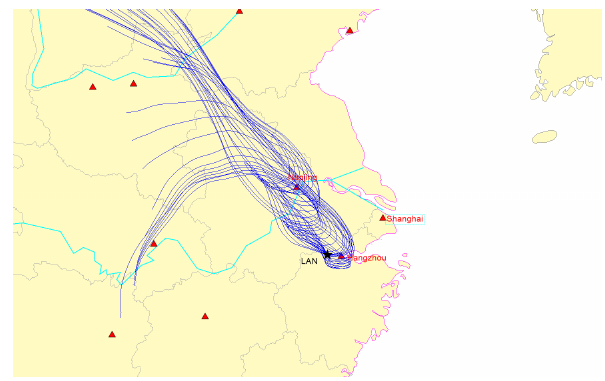
Figure 8. HYSPLIT 72h back trajectories for every hour from 28 December 2010 19:00 (local time) to 30 December 2010